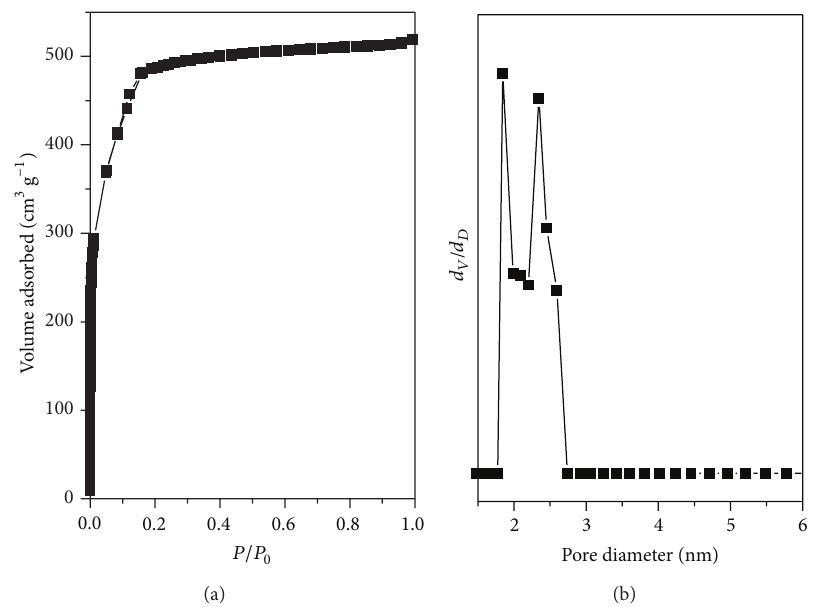
Figure 3: N 2 adsorption isotherm at − 196 ∘ C (a) and DFT pore size distribution of MIL-100(Fe) (b).